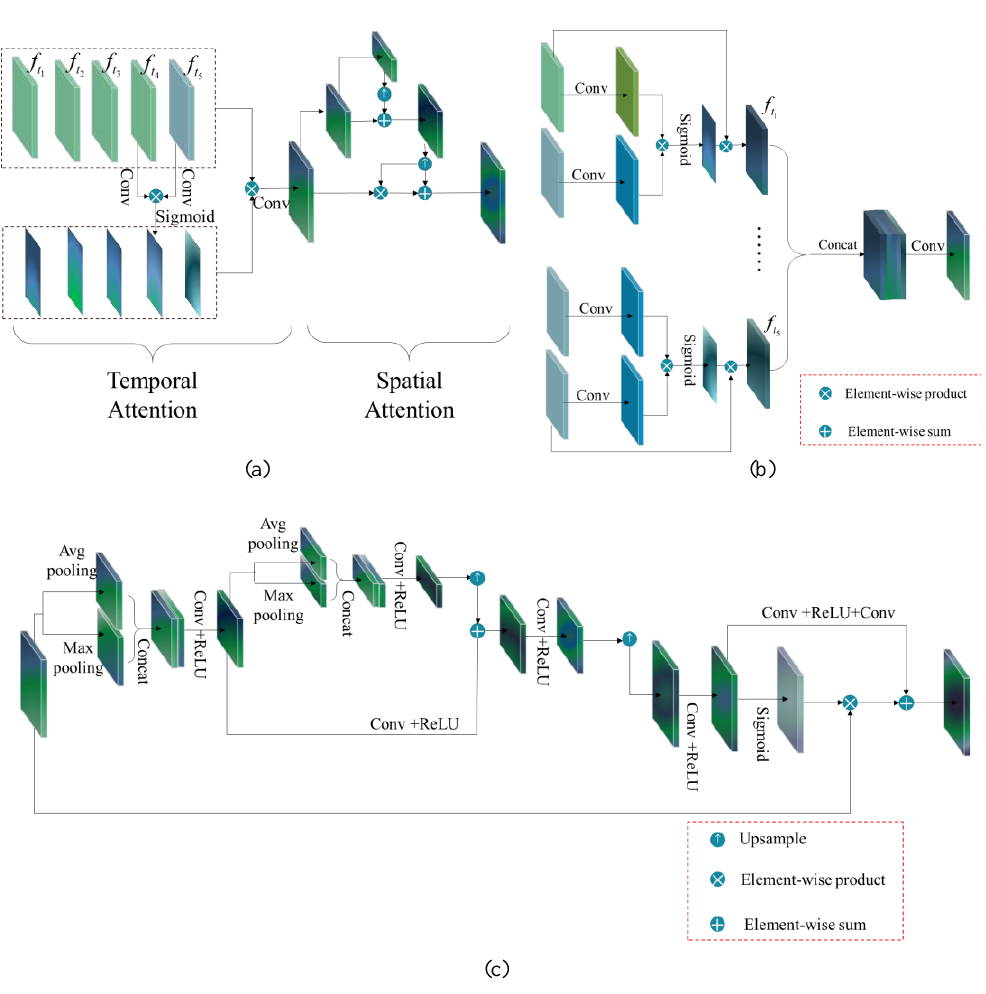
Fig. 3 the Frameworks of Temporal and Spatial Attention (TSA). (a) the overall structure for TSA (b) Temporal Attention. (c) Spatial